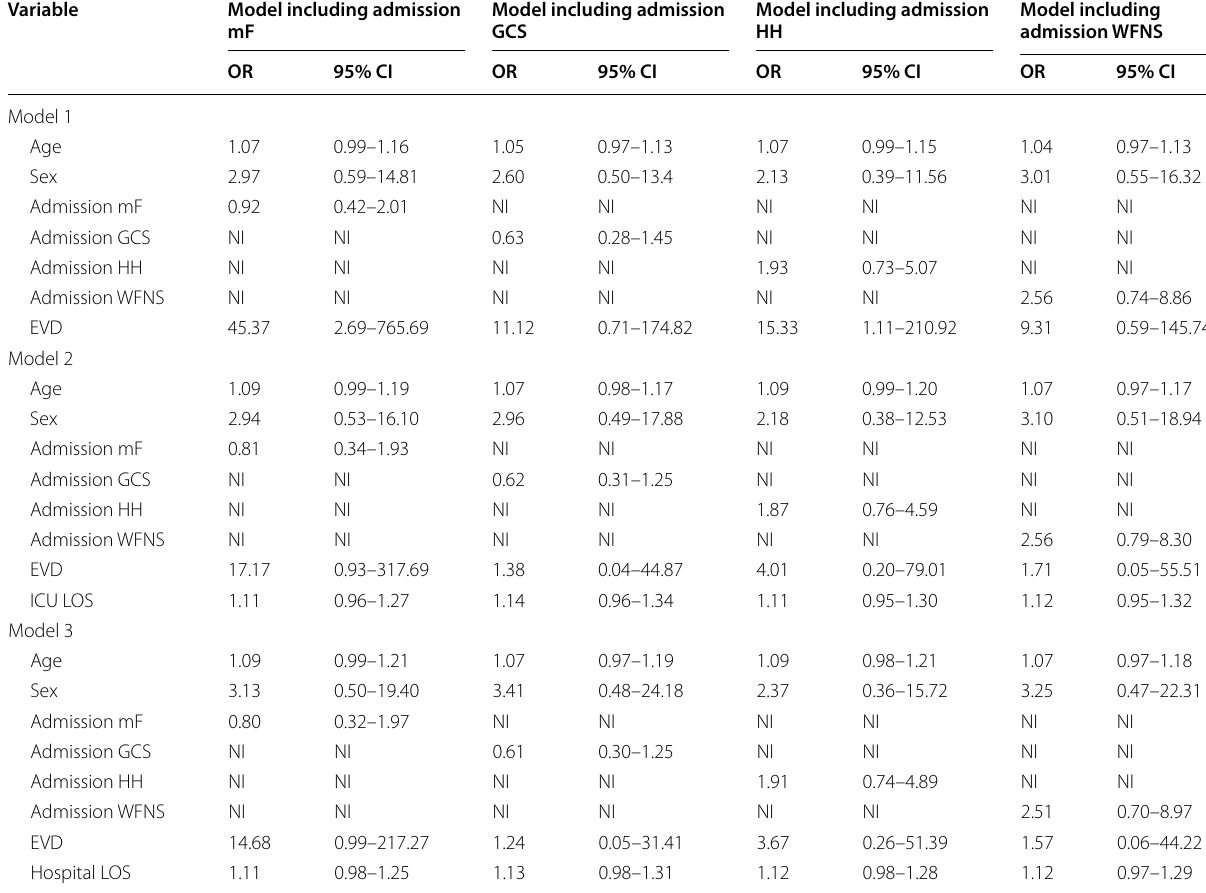
Table 3 Odds ratios in multivariable models for the outcome mRS > 2 at